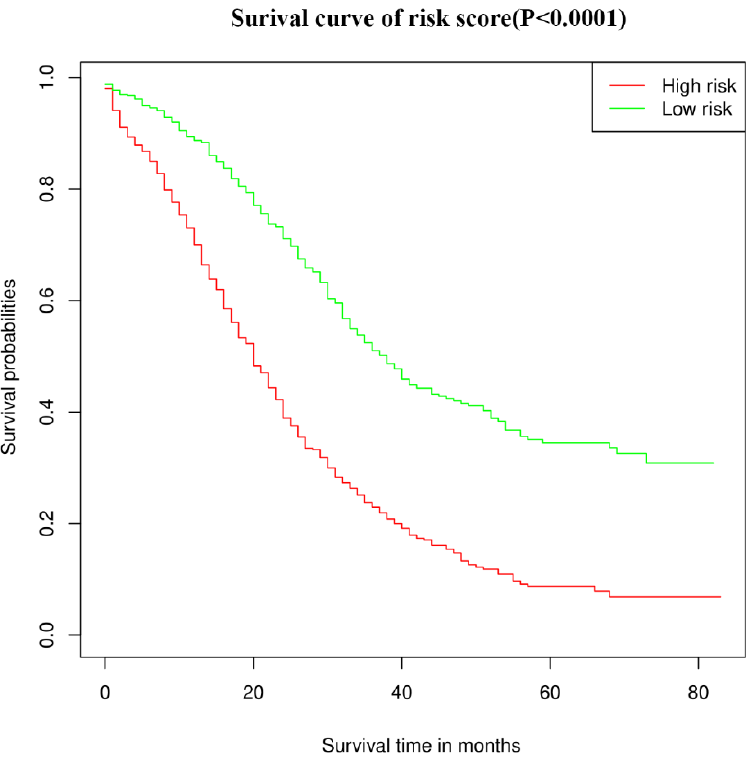
Figure 5. Kaplan–Meier survival curve of the CSS in the high- and low-risk groups.